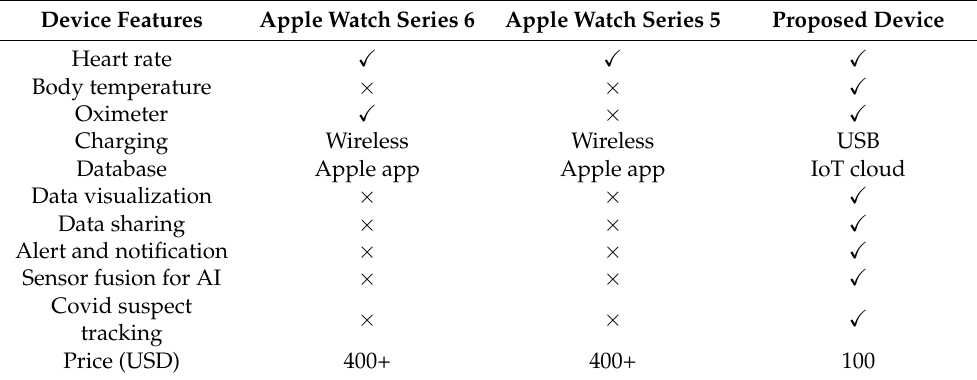
Table 1. Comparative study of the commercial device and proposed